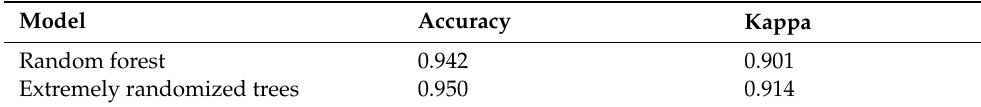
Table 7. Overall performance metrics of the ML models.